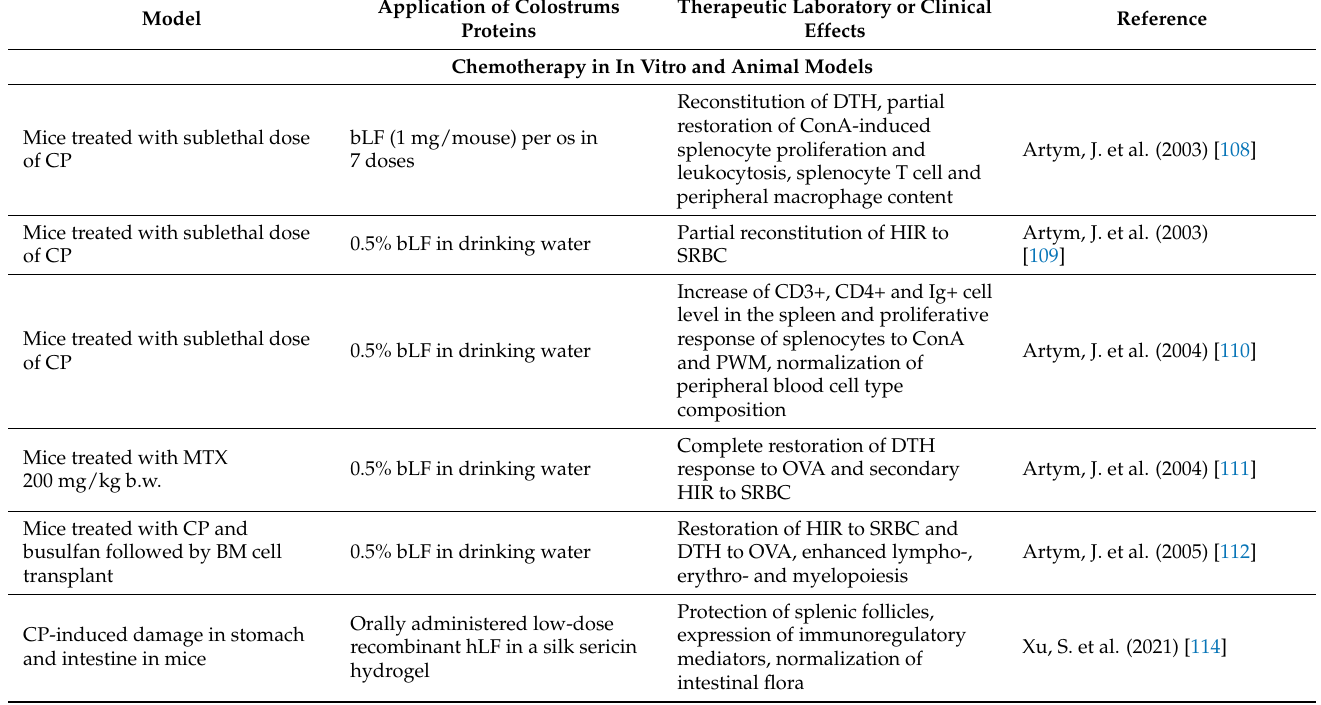
Table 2. Protective and therapeutic effects of BC and LF in the supportive care in cancer chemo- and radiotherapy. The in vitro/ex vivo, animal and human studies are